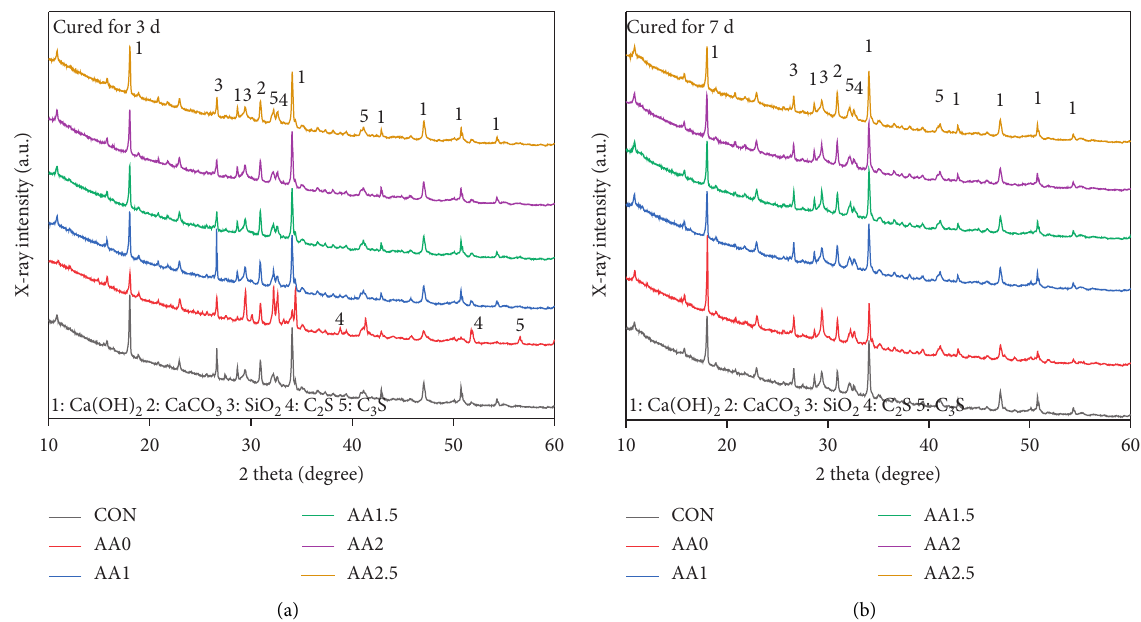
Figure 10: The XRD patterns of paste cured for 3d and 7 d: (a) 3d pastes; (b) 7d pastes.